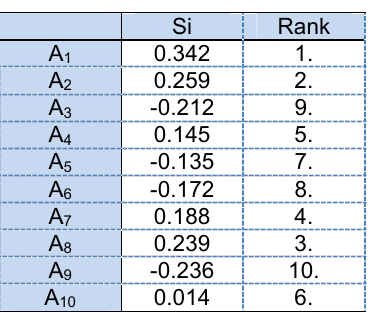
Table 14 – Rank of the alternatives Таблица 14 – Рейтинг альтернатив Tabela 14 – Rang